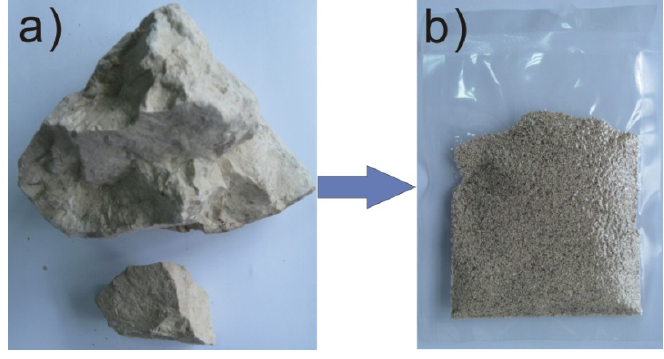
Figure 2. ( a ) The natural zeolite mineral from Jinyun, Zhejiang province, China; ( b ) The packed natural zeolite granules (manufactured by Zeo-Innov Medical Technology Corporation, Hangzhou, Zhejiang province,